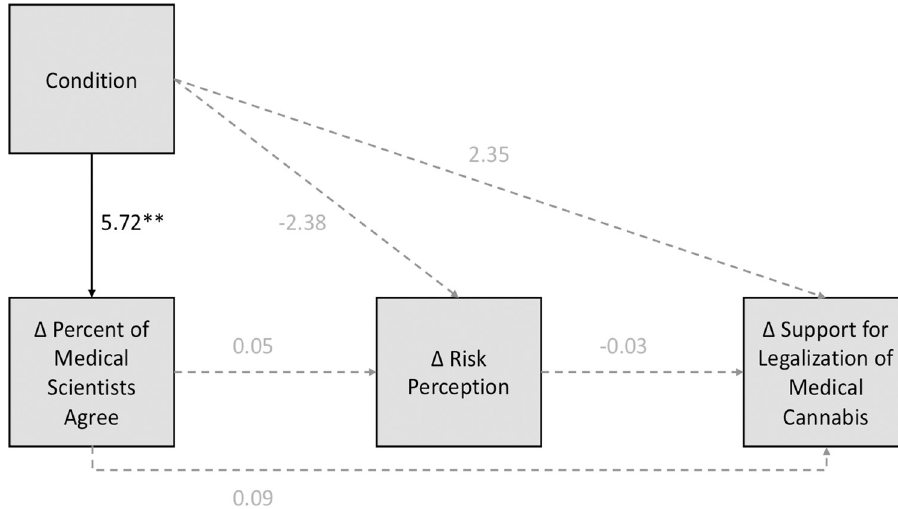
Fig 3. Modified version of the GBM for medical cannabis using pretest/posttest data (change scores). All shown paths were tested but the only significant path was from the message manipulation to the change in estimated percent of agreeing scientists. Note that condition only reflects the descriptive norm/authority message versus the control message and does not include the evidence message.